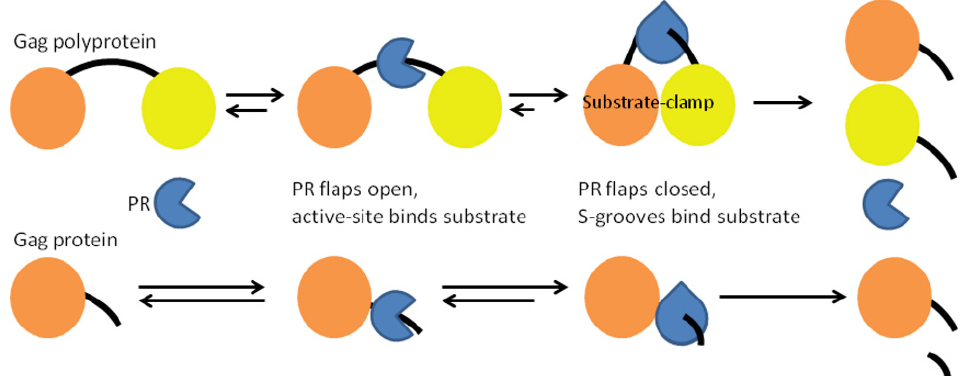
Figure 9. Schematic diagram of HIV-1 PR binding to and cleaving Gag substrates: top, Gag poly- protein with two spheres (representing structured subdomains) joined by black line (unstructured linker) represents full-length Gag, NC-SP2-p6, and MA-CA-SP1 substrates; bottom, Gag protein with one sphere (representing structured subdomain) and a black C-terminal tail represents CA- SP1 and NC-SP2 substrates. PR flaps open (blue open pie) with substrate residues P4-P4 ′ bound in active site; PR flaps closed (blue tear drop) with cleavage site residues P12-P5/P5 ′ -P12 ′ bound in S- grooves, and residues P4-P4 ′ bound in active site. Substrate-clamp formation indicated for Gag pol- yprotein. Shorter forward arrows for Gag polyprotein indicates relatively faster forward rates ver- sus Gag protein, shorter reverse arrows for Gag polyprotein indicate relatively slower reverse rates versus Gag protein.